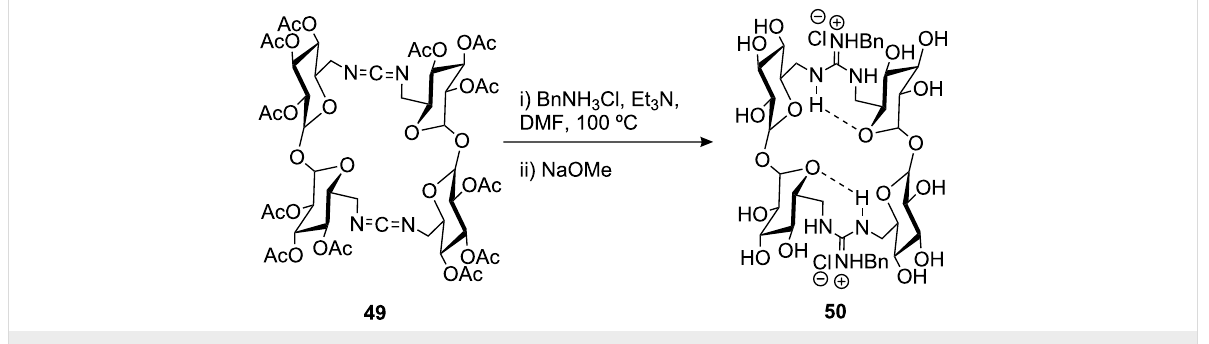
sulphur atom from a (Fmoc)-protected thiourea by Hg 2+ to provide an activated carbodiimide which can react with a free amino group to give the protected guanidine (Figure